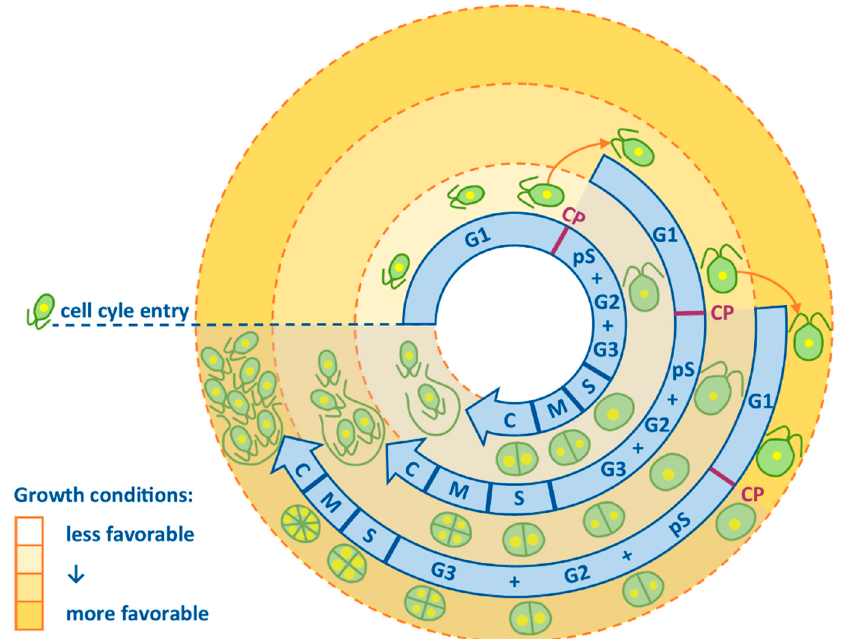
Figure 1. Multiple fission cell cycle in the model alga Chlamydomonas reinhardtii . Multiple overlapping growth and DNA replication–division sequences within one cell cycle are demonstrated as individual circle-shaped arrows. The better the growth conditions, the more growth and DNA replication–division sequences will be executed. The innermost ring represents division into two daughter cells. The combination of the innermost and the middle rings will lead to division into four daughter cells. Combination of all the circles will produce eight daughter cells. Each growth and DNA replication–division sequence can be further divided into several phases: G1 characterized by growth of the cell; then cells reach commitment point (CP) characterized by gaining the ability to divide even without further energy supply (shown by the shaded part after CP was reached); pS, the pre-replication phase; S phase during which DNA is replicated; G2 phase spanning from termination of DNA replication to the start of mitosis; M phase during which nucleus is divided; G3 phase between nuclear and cellular division and C phase, when the cell is cleaved. Adapted with permission from Bisova and Zachleder [25]. Copyright 2014 Oxford University Press, on behalf of the Society for Experimental Biology.